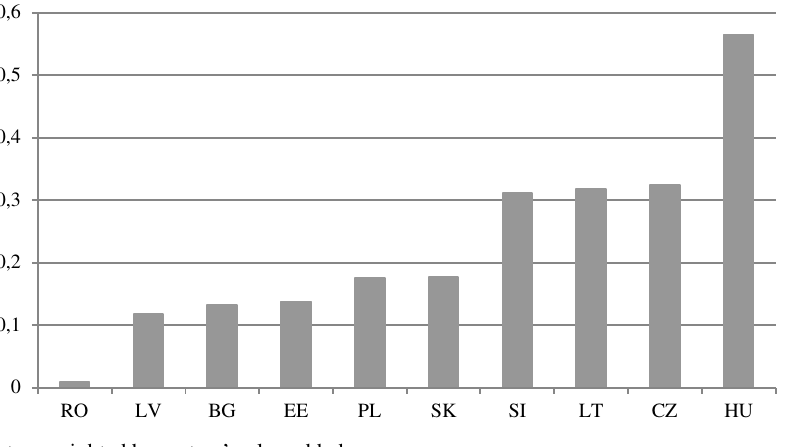
Figure 2. Relative changes in global import intensity between 2004 and 2014, by